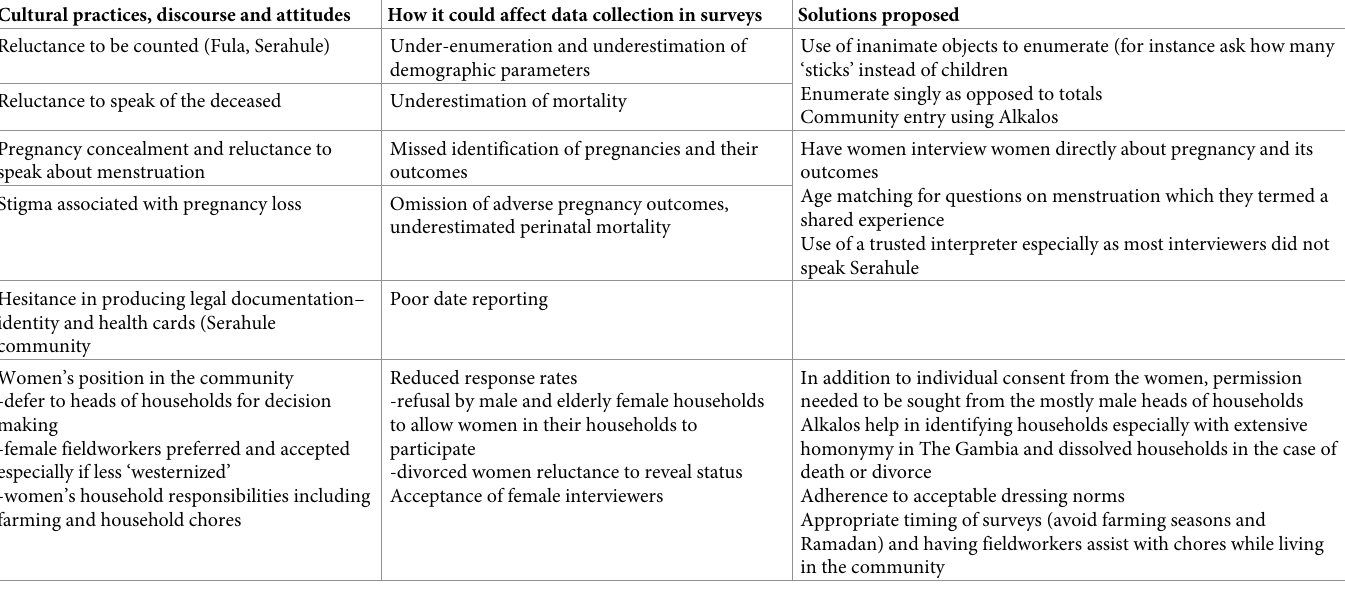
Table 2. Summary of findings, implications for surveys and proposed